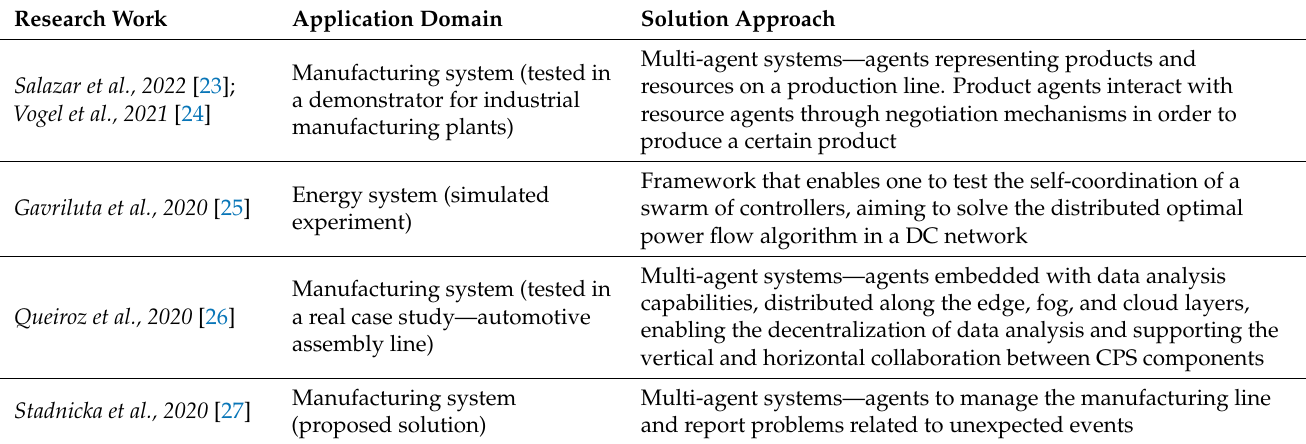
Table 2. Summary of research works that propose collective-intelligence-based CPS